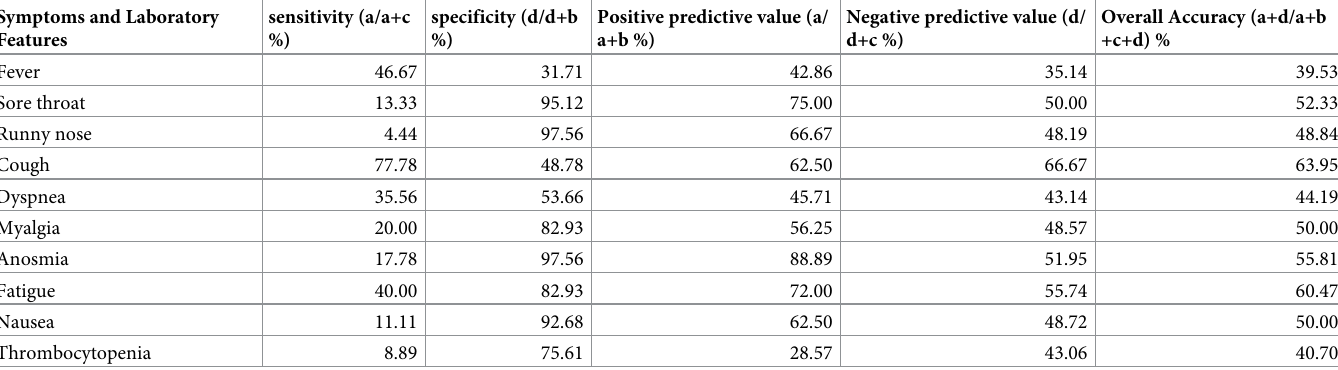
Table 6. Diagnostic accuracy of symptoms and